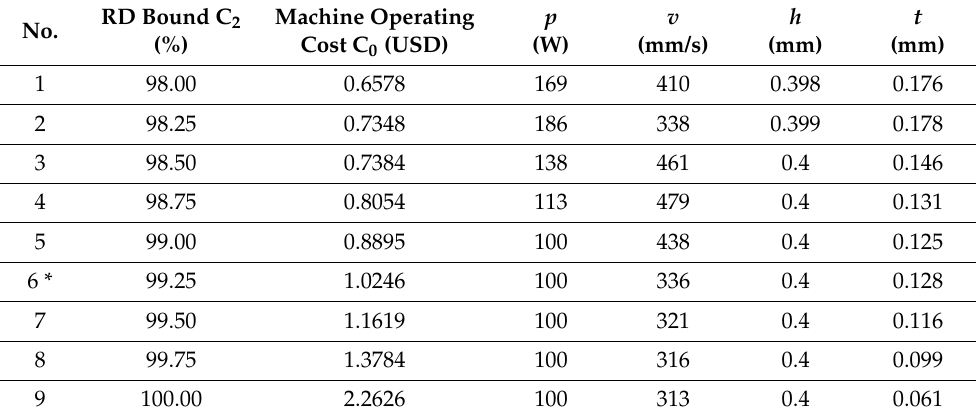
Table 5. Optimization results of Model 2 for different relative density bounds ( C 2